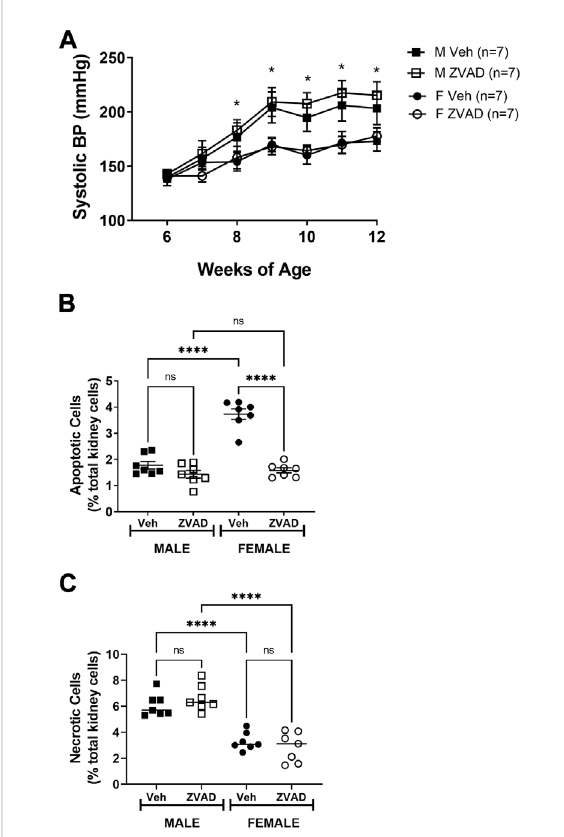
FIGURE 7 Treatment with ZVAD-FMK for 6 weeks starting prior to the developmentofhypertension didnot change BPinmaleor female SHR. Systolic BP was measured by tail-cuff in male (M) and female (F)spontaneouslyhypertensiverats(SHR)treatedwithvehicle (veh) or ZVAD-FMK (ZVAD) from 6 to 12 weeks of age [ n = 7; panel (A) ]. Apoptotic [panel (B) ] and necrotic [panel (C) ] cell death were measured by fl ow cytometric analysis and expressed as % of total gated kidney cells in the same rats. BP data within each sex were analyzed using repeated measures ANOVA with Tukey ’ s multiple comparisons test and between group comparisons were made by 2-wayANOVA;*indicates p < 0.05vs.femaleSHR.Flowcytometry data were compared using 2-way ANOVA followed by Tukey ’ s multiple comparisons test; **** indicates p < 0.0001; NS indicates not signi fi